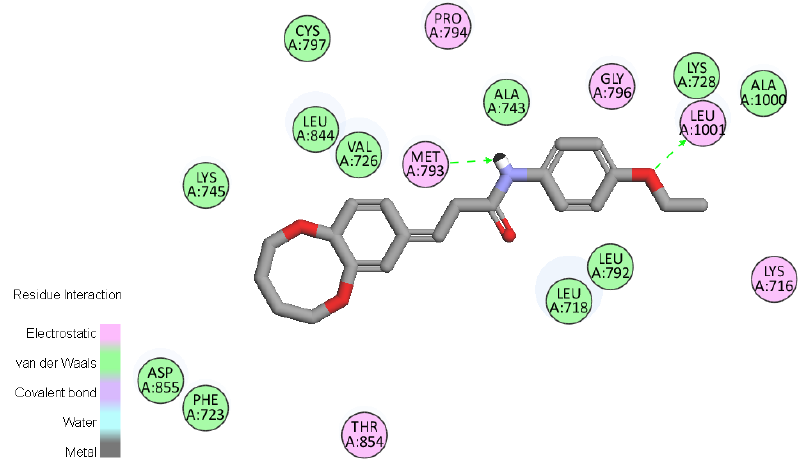
Figure 5. 2D molecular docking of compound D lines) are displayed.